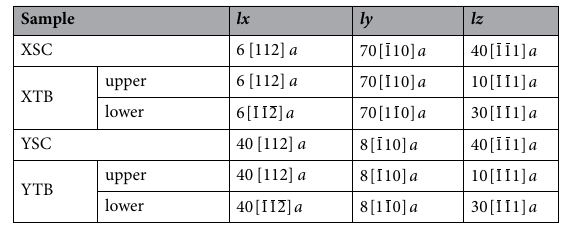
Table 3. Sizes and orientations of samples XSC, XTB, YSC and YTB. X and Y represent axis direction of cylindrical indenter. SC and TB represent single crystal and twin boundary, respectively. a = 4.12 Å is lattice